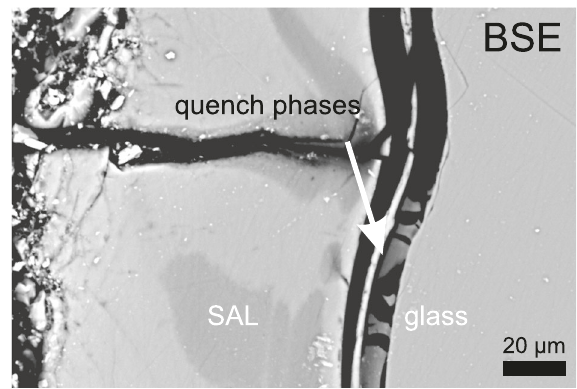
Fig. 6 Gap formation. Backscattered electron image taken after the experiment from a polished section that was prepared from the dried glass window. Note the occurrence of a gap/crack marking the interface between the pristine glass and the